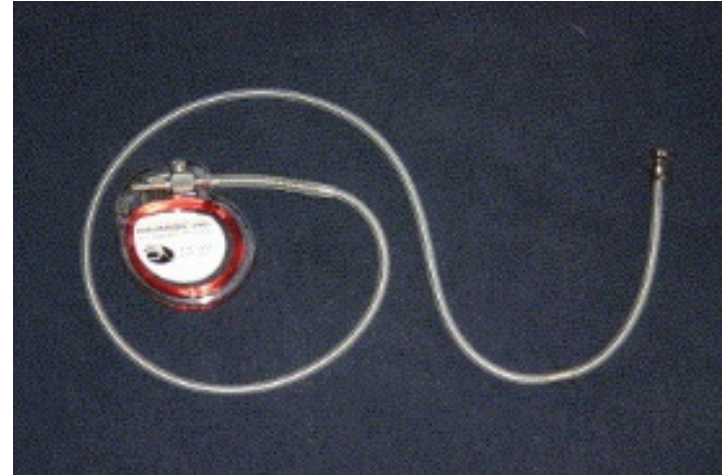
Figure 10. The HeartPOD Left Atrial Pressure (LAP) sensing device. Reprinted from Heart, Lung and Circulation, Volume 14, Issue 2, Walton et al., The HeartPOD Implantable Heart Failure Therapy System, Pages S31-S33, Copyright 2005, with permission from Elsevier [36].